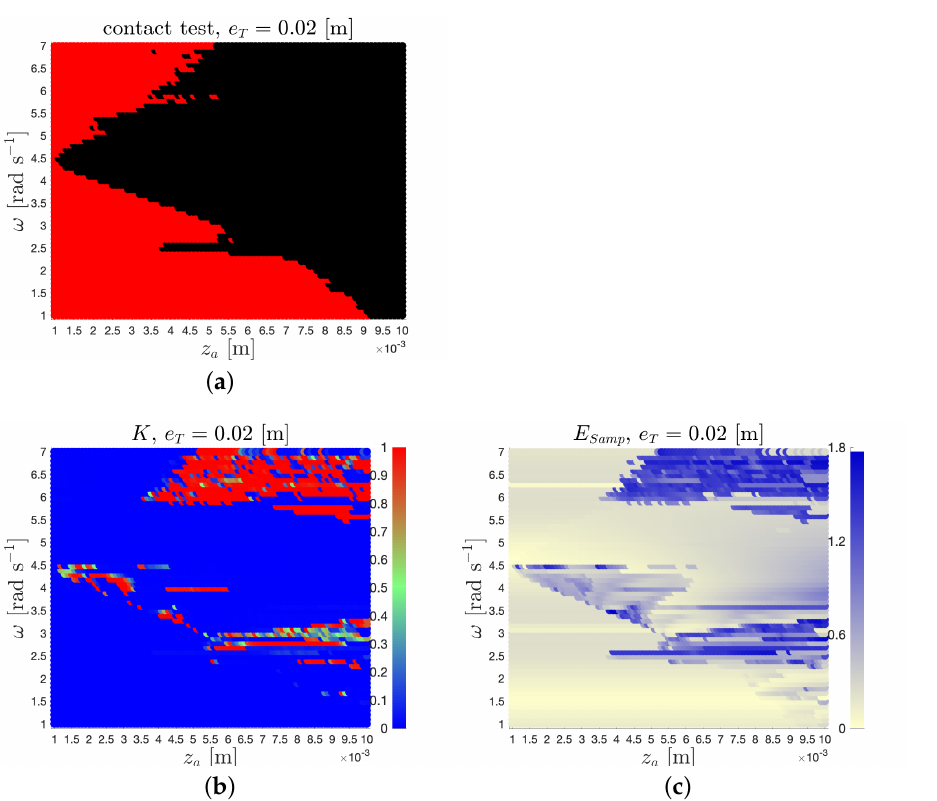
Figure 15. Outputs of the contact test ( a ), the 0–1 test for chaos K ( b ), and sample entropy E Samp ( c ) for eccentricity e T of 0.02 m with respect to the excitation frequency ω and amplitude z a